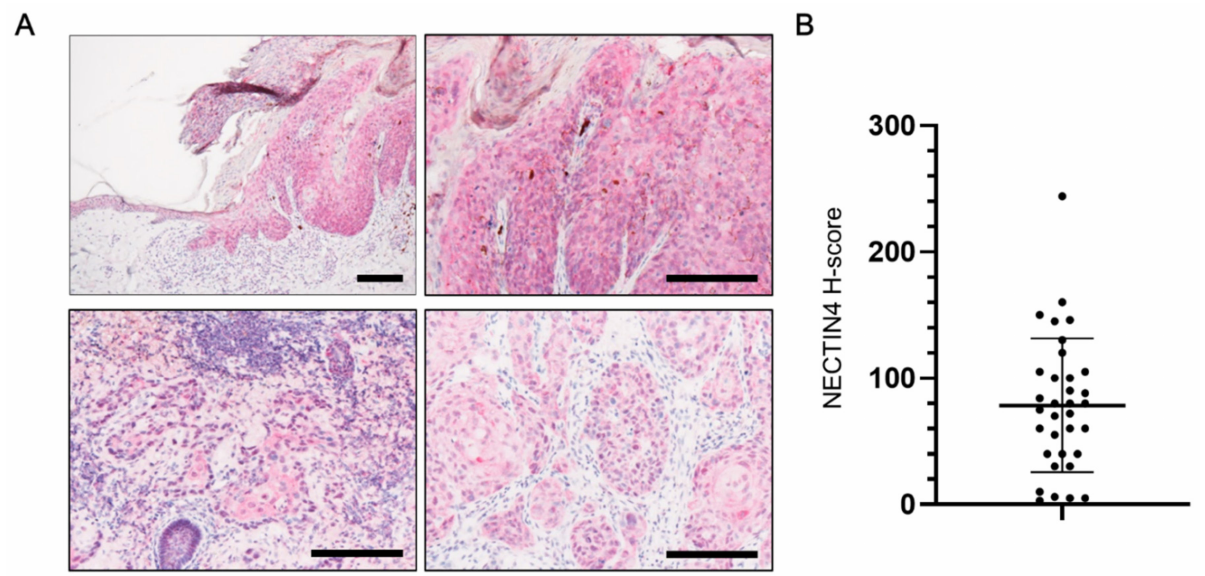
Figure 1. NECTIN4 expression in human cutaneous squamous cell carcinoma (cSCC) tissues. ( A ) Representative immuno- histochemical images of NECTIN4 staining (red) in tissues from cSCC patients. ( B ) Mean ( ± SD) H-scores for NECTIN4 staining intensity in tissues from cSCC patients ( n = 34). Symbols indicate H-scores in individual patients. Scale bars: 200 µ